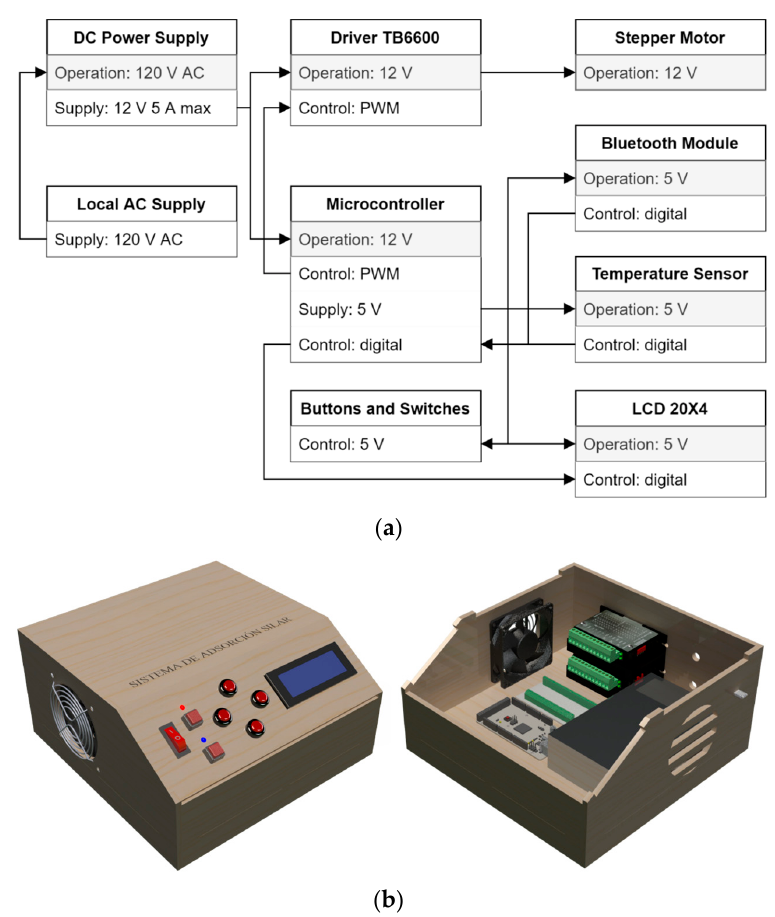
Figure 4. Automated mechanical system: ( a ) block diagram of the electrical and control components. ( b ) Design of the control panel console. Table 1. Transition states of the finite-state machine for the automated mechanical